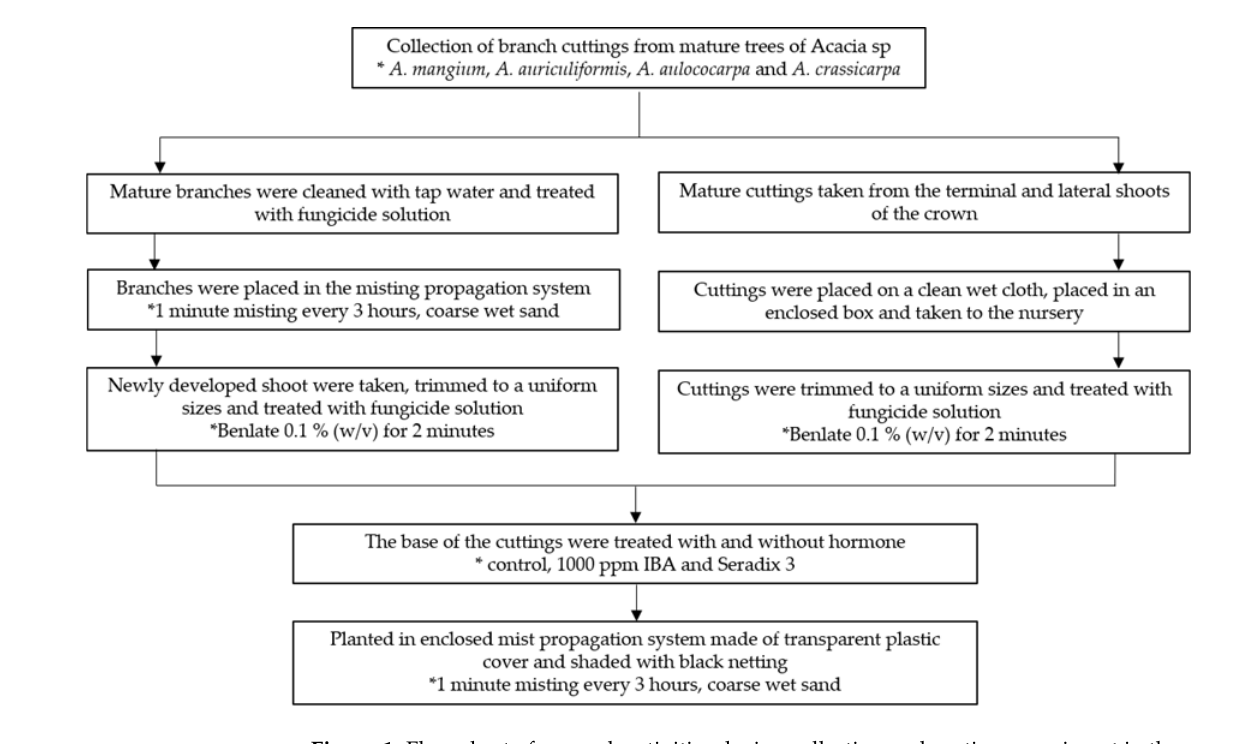
Figure 1. Flow chart of research activities during collection and rooting experiment in the nursery for the production of quality planting material of Acacia species. (* Specific concentration and time).